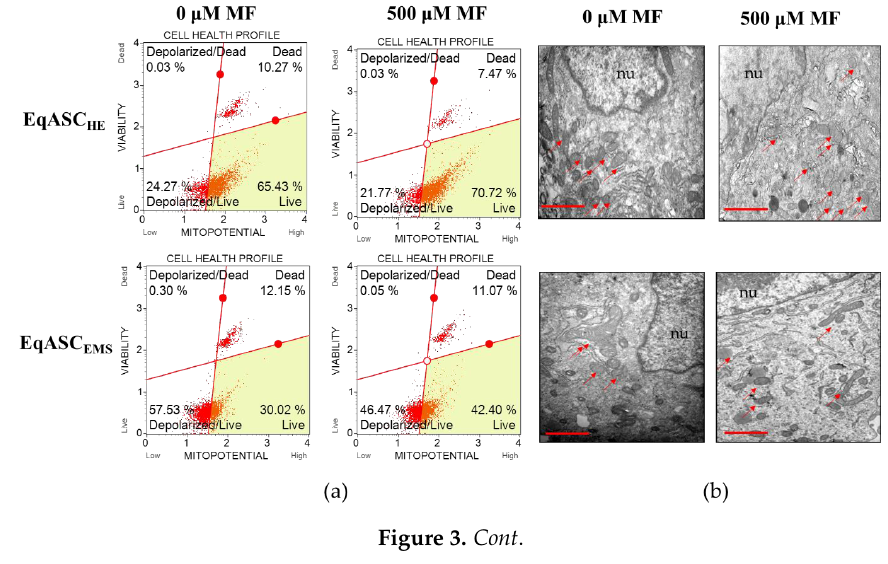
Figure 2. The influence of metformin on the distribution of EqASCs during the cell cycle, with representative histograms ( a ) and results of statistical analysis ( b ). The statistically significant changes are indicated with asterisks; * p < 0.05; ** p < 0.01 and *** p < 0.001. Non-significant differences are marked as ns .